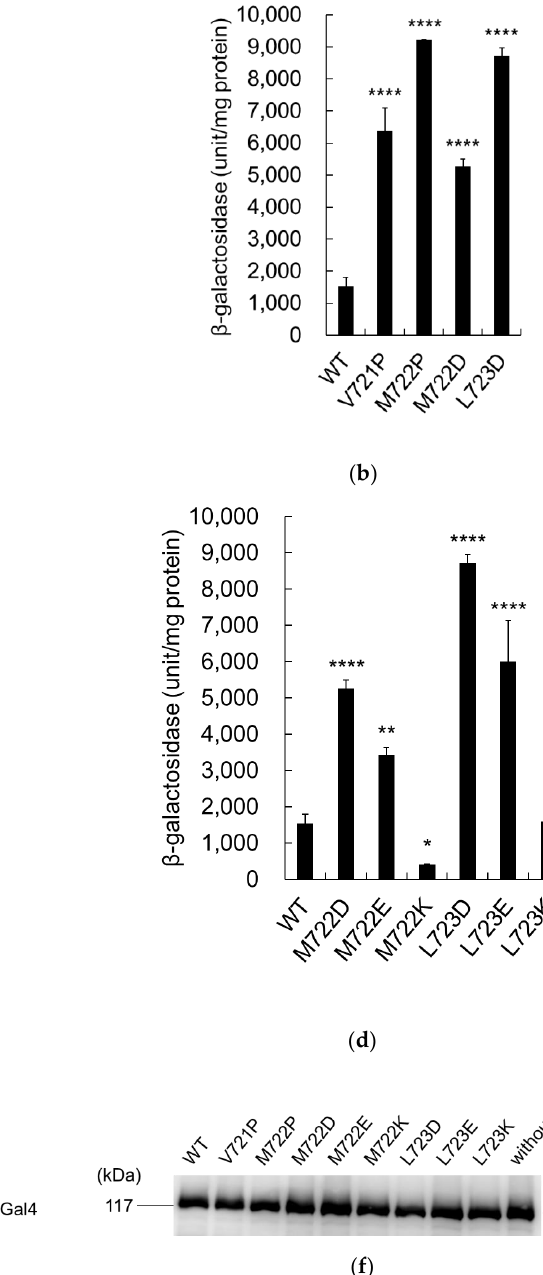
Activity was normalized to that of the control cells without PS1 (61 units/mg protein for ( a , c ) and units/mg protein for ( b , d )). Asterisks indicate p < 0.0001 (****), p < 0.001 (***), p < 0.01 (**), or p < 0.05